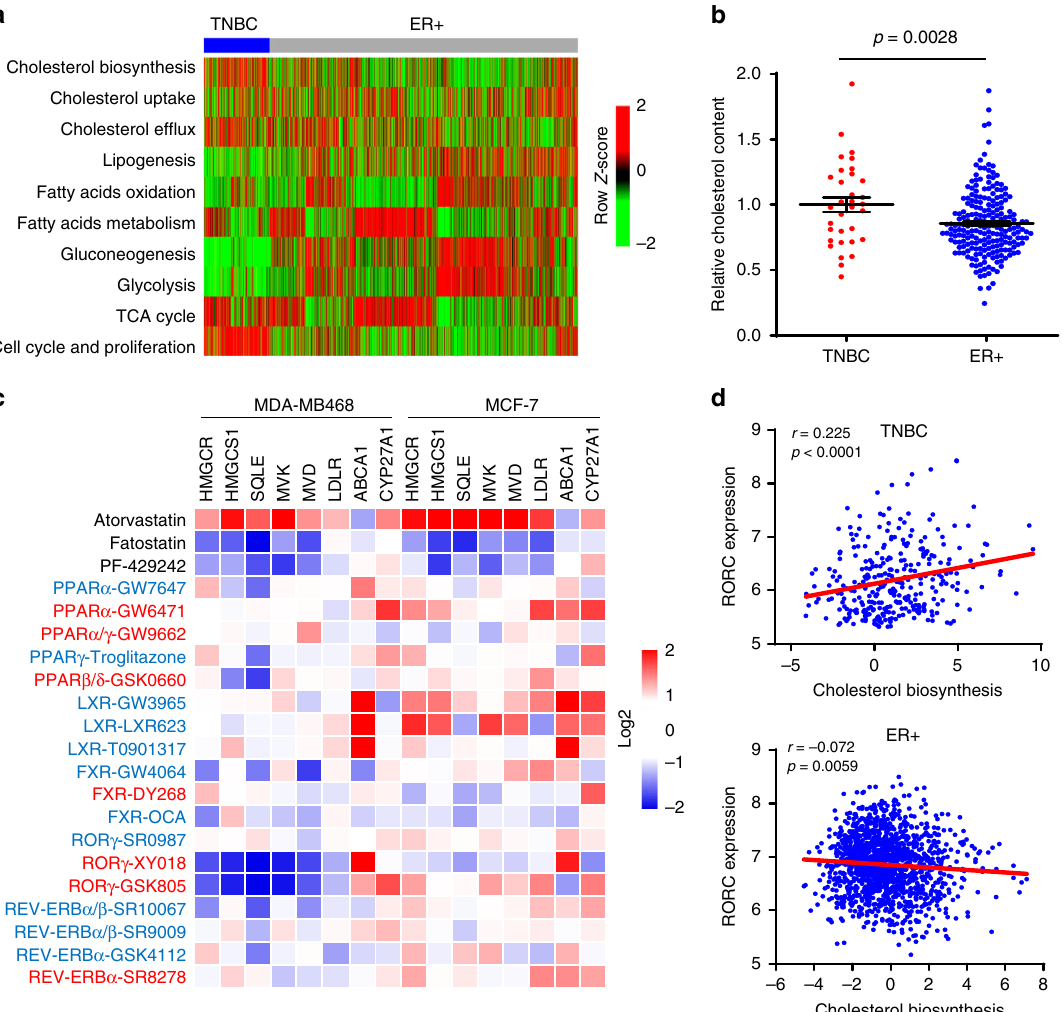
Fig. 1 A hyper-activated cholesterol-biosynthesis program is linked to ROR γ in TNBC. a Heat map of activity scores of gene expression of indicated pathways with data normalized from − 2 (Green) to 2 (Red) in tumors of TNBC (313 patients) and ER + cancer (1459 patients). The gene expression datasets were from METABRIC consortium. For each of the ten metabolic pathways and cell cycle/proliferation pathway, a gene set was manually compiled, and an “ activity score ” was represented by the fi rst principal component of the gene set for each of the ER + or TNBC samples. b Relative cholesterol contents of 33 TNBC tumors and 218 ER + tumors were measured with GC – TOFMS. Student ’ s t test. P = 0.0028. c Heat map display of fold changes (in log2) in cholesterol homeostasis gene expression in MDA-MB468 and MCF-7 cells treated for 48 h by agonists (blue) or antagonists (red) of indicated NRs. The concentration was 2.5 µ M for each compound. The expression of indicated genes was analyzed by qRT-PCR. The experiments were repeated three times. d Scatter plots showing correlation of transcript expression between RORC and cholesterol-biosynthesis pathway in TNBC and in ER + tumors. The Pearson correlation metric was computed by using the ‘ cor ’ function in R. The METABRIC dataset was